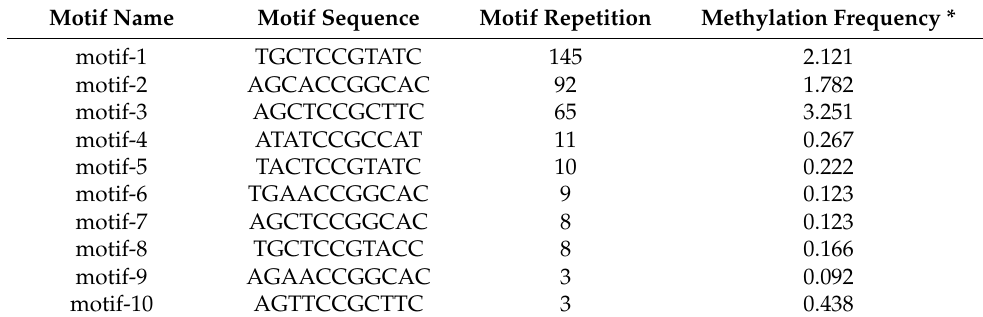
Figure 5. Overview of the distribution of motifs with methylated CG in FibH . The dots in the scatter chart and the lines in the heat map represent motifs. The frequency of methylation is marked on the right side of the graph. The sequence and methylation efficiency of the four most methylated sites are marked and indicated by a red dashed line. Table 3. Repeated motif in FibH.